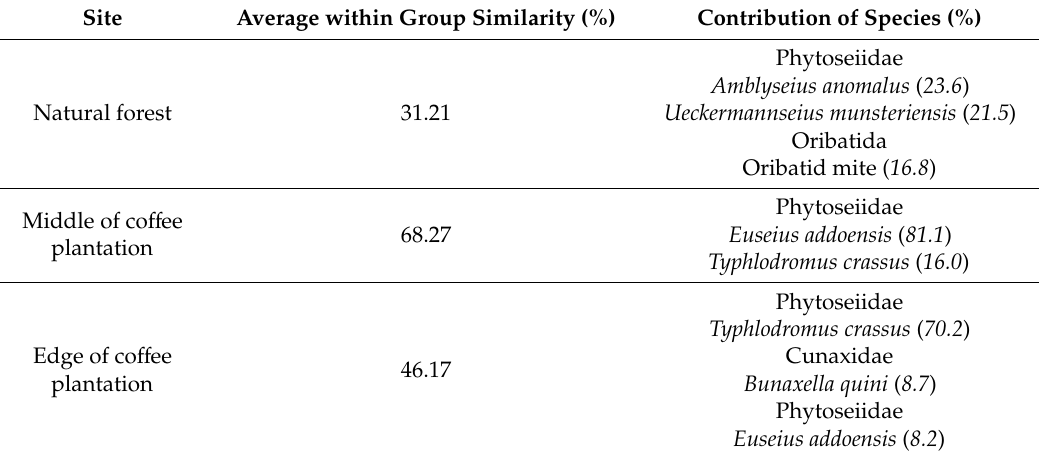
Table 2. The contribution of the mite species sampled to the average within group similarity amongst the sites sampled.